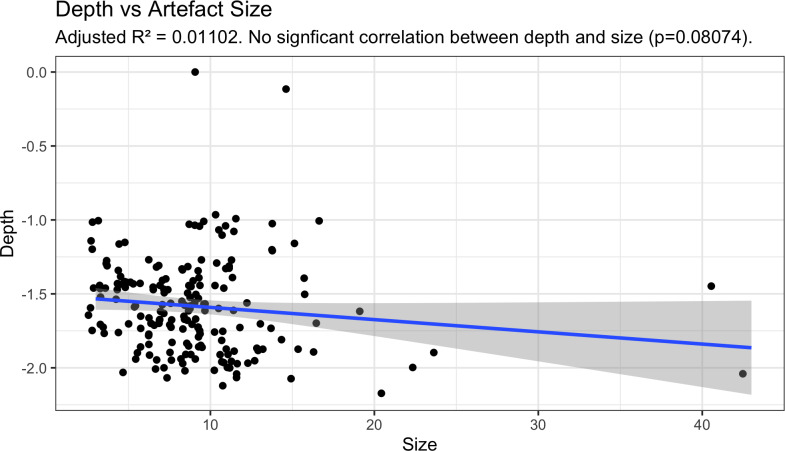
Cape Bruguieres Channel Assemblage size and location data demonstrate the absence of relationship between depth and artefact size.Plotted using the ggplot package in R [62].